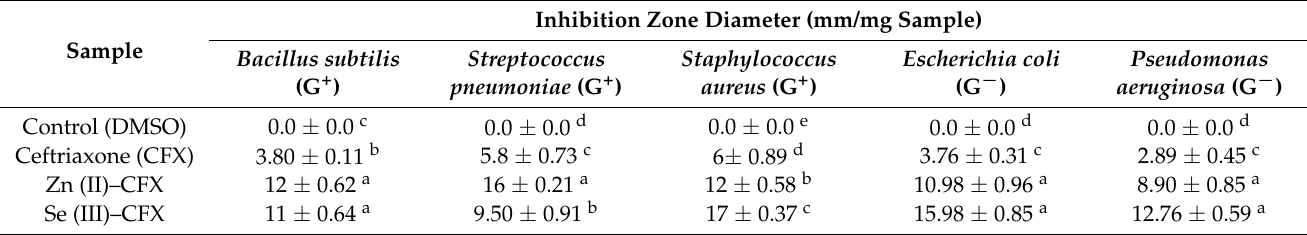
Table 7. Inhibition zone diameter (mm/mg sample) of CFX and CFX metal